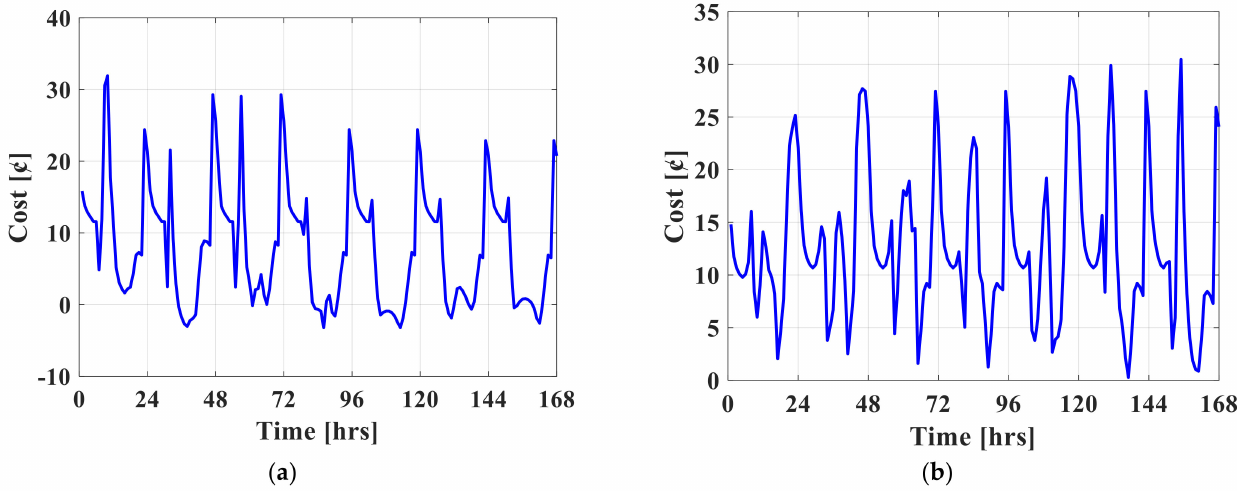
Figure 15. Electricity cost variations under ToU-ToU rates for one week in: ( a ) Summer, and ( b )